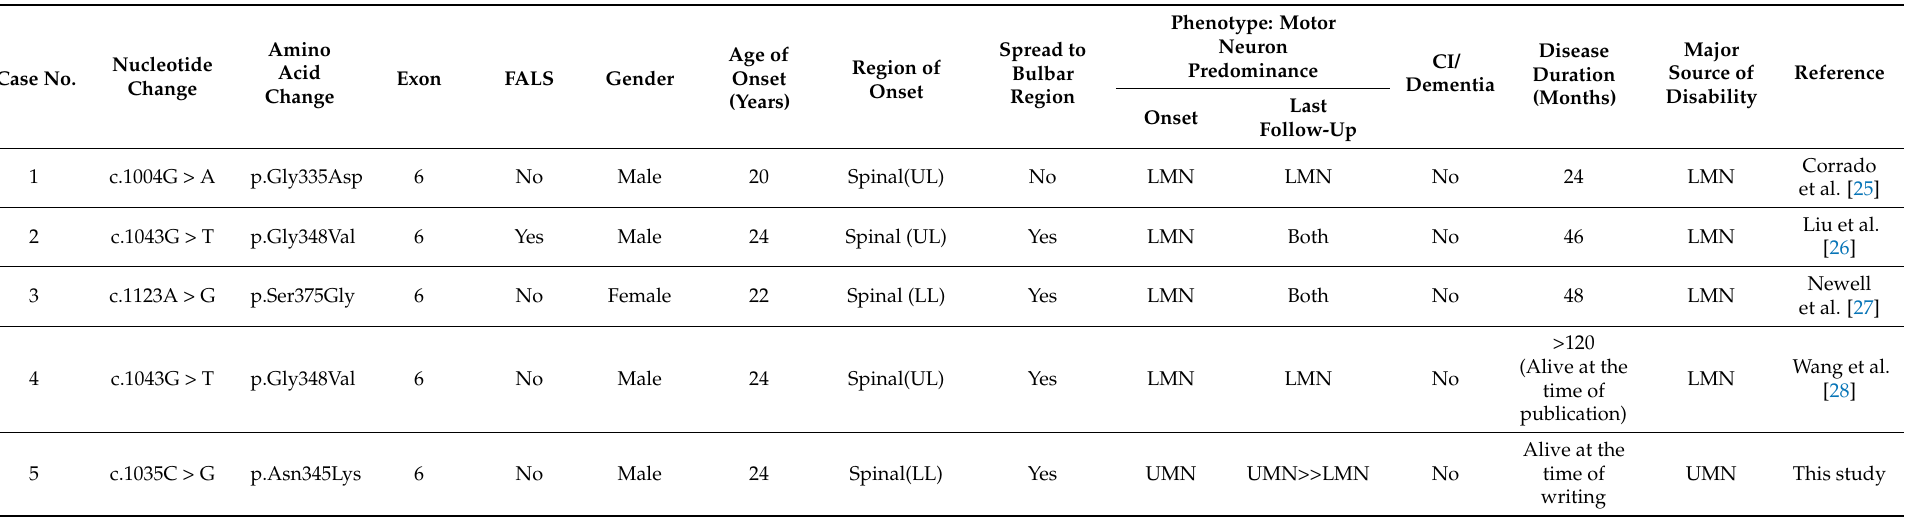
Table 1. Clinical characteristics of Juvenile ALS TARDBP -associated patients. FALS: familial ALS. UL: upper limbs. LL: lower limbs. LMN: lower motor neuron. UMN: upper motor neuron. CI: cognitive